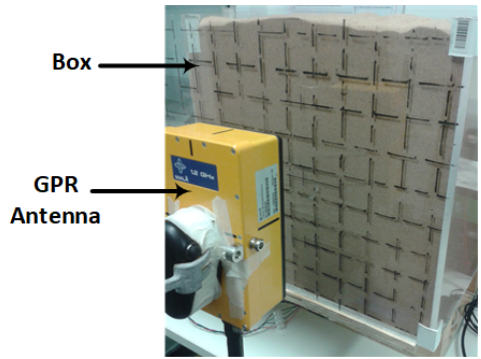
Figure 4. Setup for the GPR reflected pulse measurements. The antenna was placed 15 cm from the surface of the box.